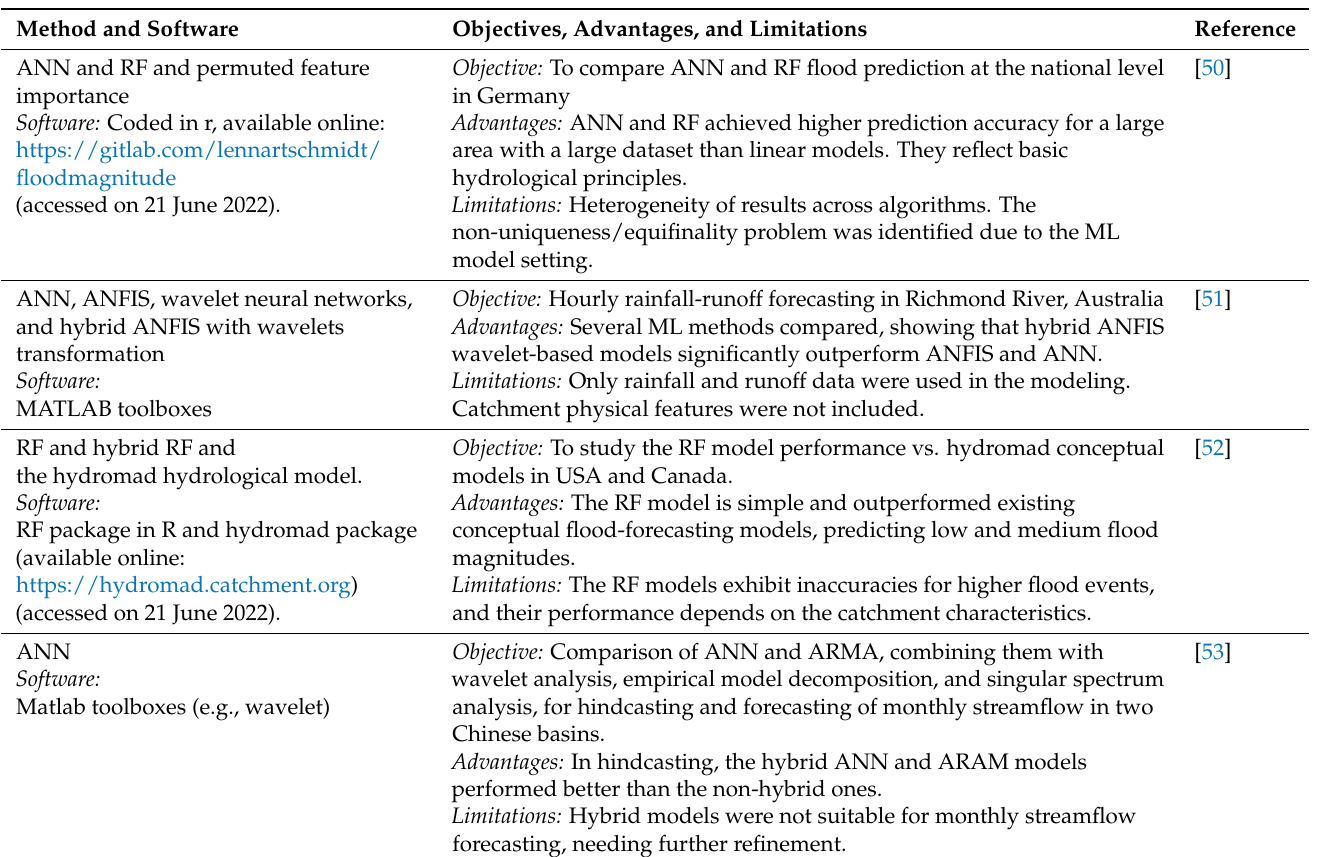
Table 2. Selected GeoAI applications in hydrological and hydraulic modeling. Objectives, Advantages, and